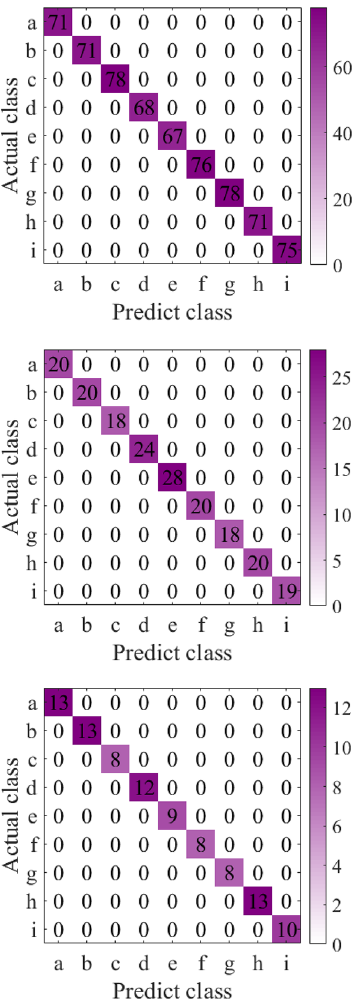
Figure 9. University of Connecticu gear fault confusion